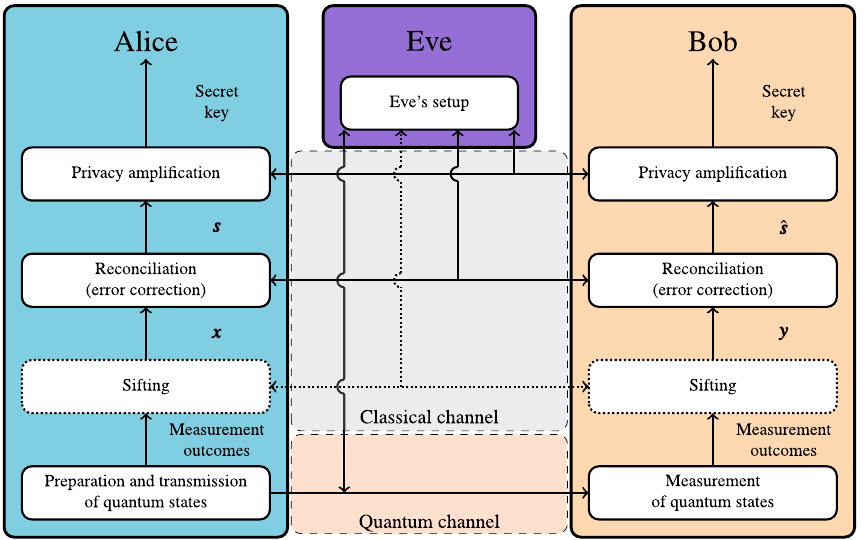
Figure 6. An overview of the CV-QKD protocol based on four different stages; transmission and measurements of quantum states, sifting, reconciliation, and privacy amplification. Eve has full access to classical channel and full control over the quantum channel. The purpose of the protocol is to ensure that at the end Alice and Bob are left with the same secret